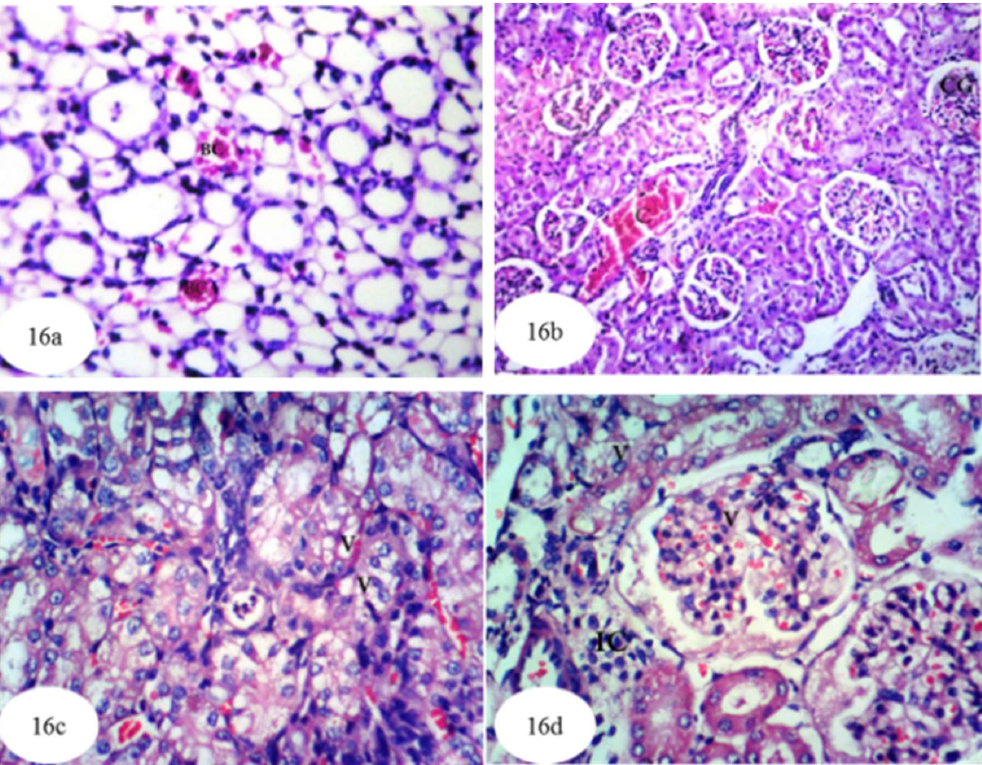
Figure 16. Photomicrographs of hematoxylin and eosin stained sections of kidney of ethylene glycol-administered rat treated with carvedilol showing red blood cells (BC) in some of the tubular lumen at the medulla ( a ) (×256); slight congestion (C) in the cortical blood vessels and glomeruli (CG) ( b ) (×128); vacuolization (V) of epithelial lining the tubules ( c ) (×400); and hypertrophy and vacuolization (V) of the glomerular tufts, vacuolization of epithelial lining renal tubules and perivascular inflammatory cells (IC) infiltration ( d ) (×400).